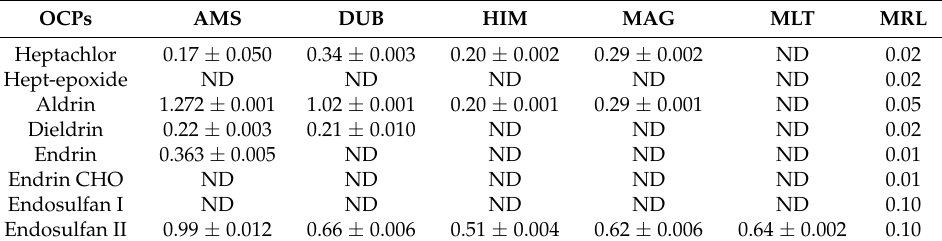
Table 3. Mean concentrations of cyclodienes (mg/kg) isomers in Malt Drink.